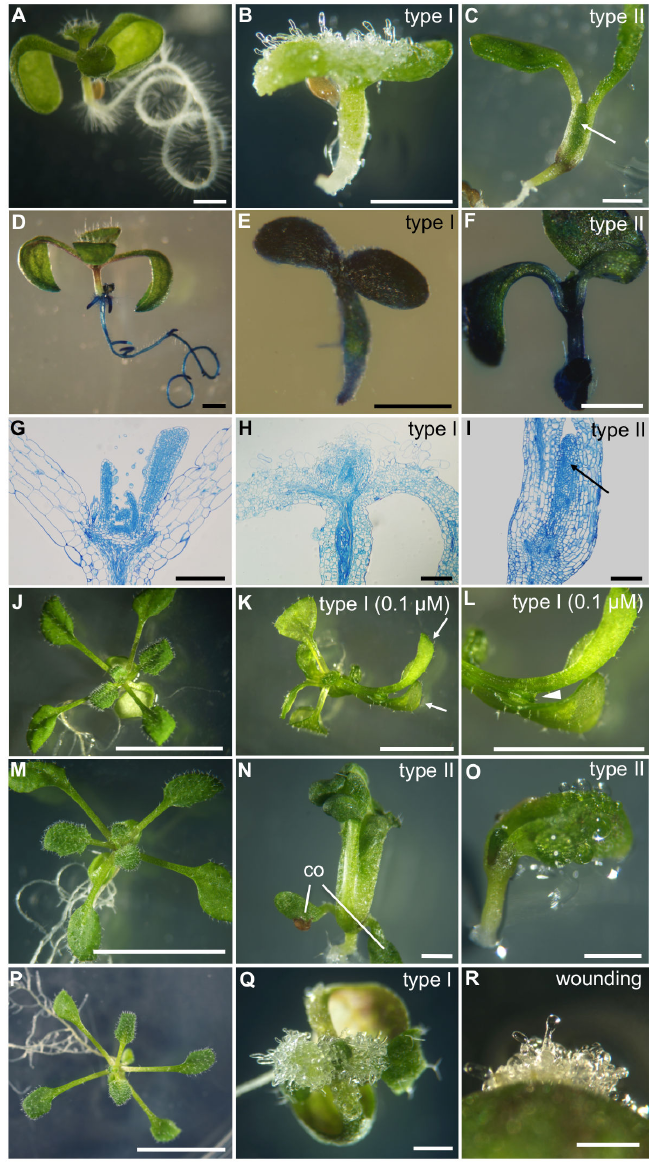
Figure 2. Phenotypes of ATML1-SRDX lines. ( A – C ) Seven-day-old seedlings of the wild type (A), a type I ATML1-SRDX line (B), and a type II ATML1-SRDX line (C) grown on MS-phytagel plates containing 10 μM estradiol. The arrow indicates fused leaves formed at the shoot apex. ( D – F ) Seven-day-old seedlings of the wild type (D), a type I ATML1-SRDX line (E), and a type II ATML1- SRDX line (F) grown with 10 μM estradiol and stained with toluidine blue (blue color). ( G – I ) Longitudinal sections of seven-day-old wild-type (G), type I ATML1-SRDX (H), and type II ATML1-SRDX seedlings (I) grown with 10 μM estradiol and stained with toluidine blue. The arrow in I indicates a leaf primordium. In Figure 2G–2I, toluidine blue staining was performed after sectioning to visualize the cell boundaries. ( J ) A 16-day-old seedling of the wild type grown with 0.1 μM estradiol. ( K ) Fused leaf development (arrows) in a type I ATML1-SRDX line grown with 0.1 μM estradiol for 16 days. ( L ) Magnified view of the fused leaves in K. The arrowhead indicates a junction of the fused leaves. ( M ) A 14-day-old seedling of the wild type grown with 10 μM estradiol. ( N ) Fused leaf formation in a type II ATML1-SRDX line grown with 10 μM estradiol for 14 days. co, cotyledon. ( O ) An eight-day-old seedling of a type II ATML1-SRDX line grown with 10 μM estradiol. Droplets of water were seen on the surface of the seedling. ( P , Q ) 14-day-old seedlings of the wild type (P) and a type I ATML1-SRDX line (Q) germinated on estradiol-free MS plates and transferred to 10 μM estradiol-containing plates after 5 days. Filamentous protrusions were formed on the surface of the leaves. ( R ) Calli formation from the cut end of a wild-type Columbia cotyledon. Scale bars, 1 mm for A–F, N, O, Q, R; 1 cm for J, M, P; 5 mm for K, L; and 200 μm for